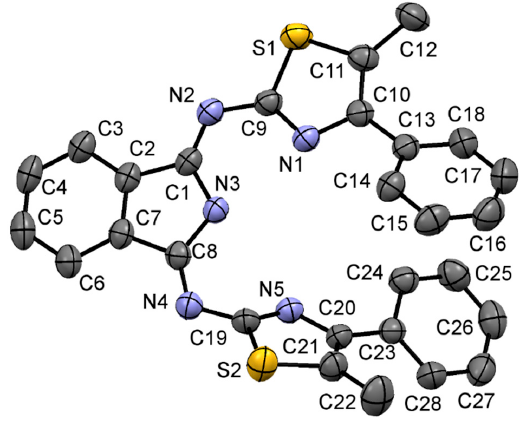
Figure 1. X-ray structure of 1 .